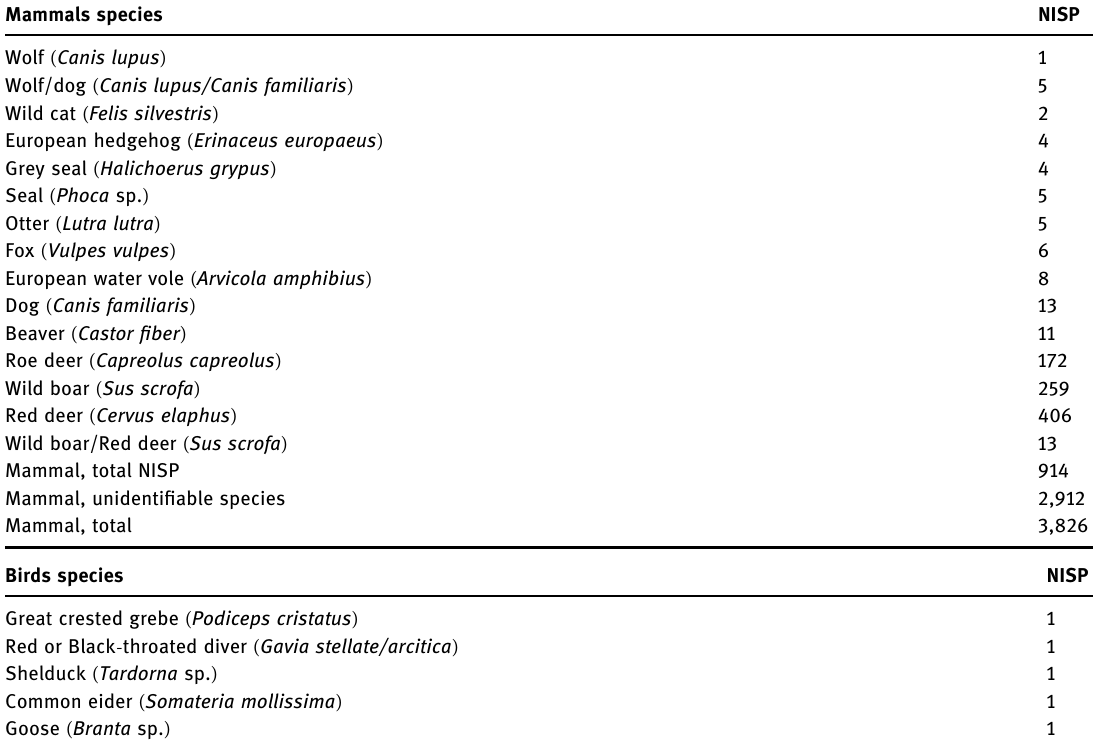
Table 3: Species determination of animal bones from Orehoved Sejlrende , Number of Individual Specimens ( NISP ) ( Brodersen, 2019; Magnussen, 2019b )